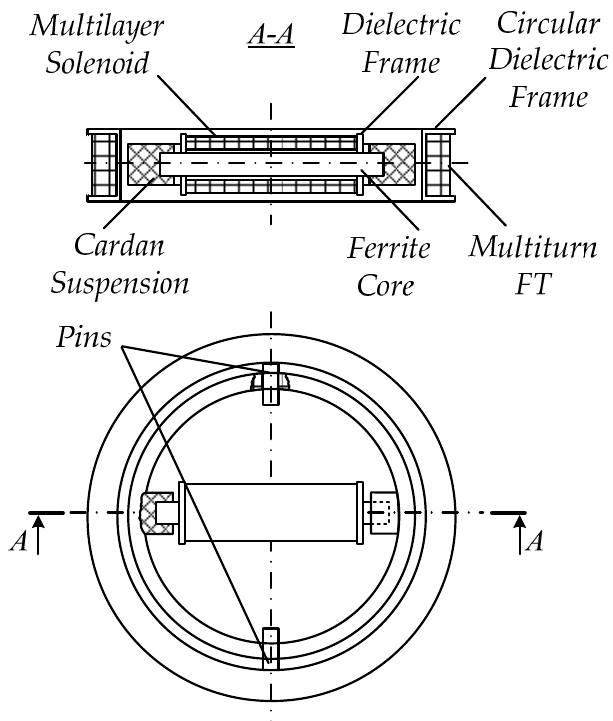
Figure 4. Layout of an induction probe featuring a frame emitter and a ferrite receiver in a coplanar position.